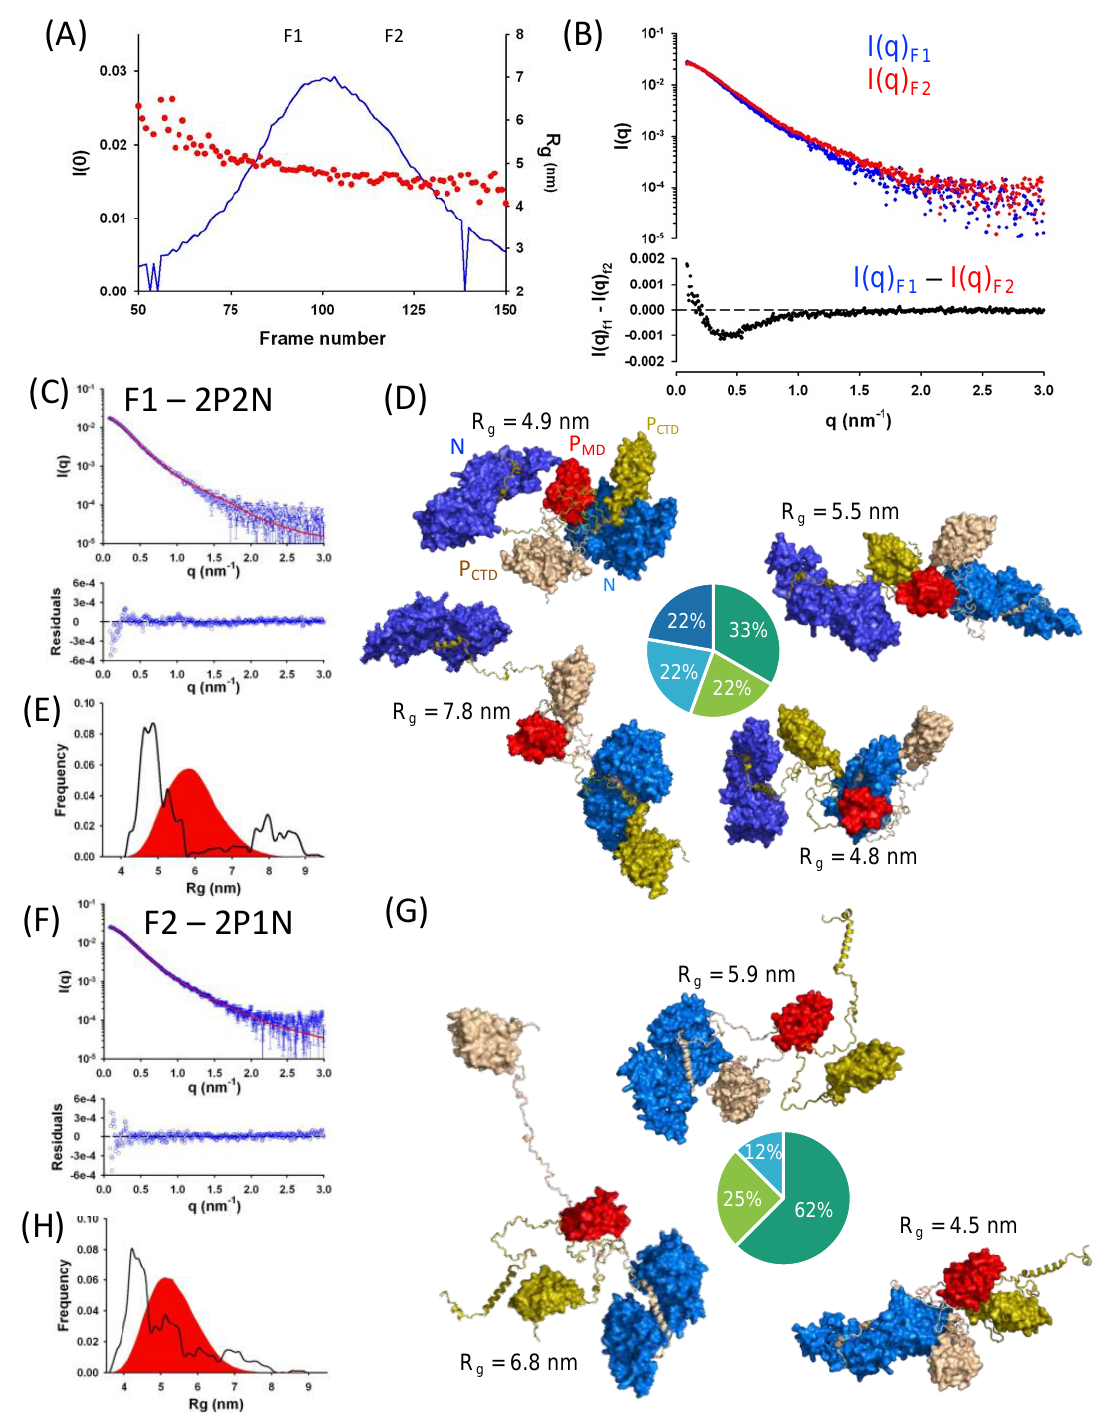
Figure 7. SEC-SAXS of N ∆ 230 − P FL complex. ( A ) SEC-SAXS elution profile and R g across the elution peak; 50 µ L of N ∆ 230 − P FL sample were injected onto a Superdex 200 column and monitored on-line by SAXS. The blue line shows the intensity at zero angle (I 0 ), which is proportional to both MM and concentration. The red dots indicate the values of the radius of gyration calculated from the Guinier approximation at the different time intervals. The shaded areas (labeled F1 and F2) show the frames that were averaged and used for analysis in the next panels. ( B ) Average SAXS profiles at two different positions in the SEC profile. The upper part shows the curves obtained by averaging the individual profiles recorded across the two fractions (F1 and F2) of the SEC elution peak shown in Panel ( A ). The lower part shows the difference scattering profile (I(q) F1 –I(q) F2 ). ( C ) Conformational ensemble modeling by the ensemble optimization method (EOM). The upper panel show the exper- imental F1scattering profile (blue circles) The red line shows back-calculated scattering curve for a selected ensemble of 4 2P − 2N conformers shown in panel E ( 2 = 1.95). The lower panel shows the plot of the residuals (blue circles). ( D ) Representative ensemble of conformers that reproduce the curve at position F1. The pie chart indicates the fraction of each conformer used in the calculated curve. The dimerization domain of P (P MD ) is shown in surface representation in red. The rest of the chains of P are shown in wheat and olive and the C-terminal domains (P CTD ) are shown in surface representation, while the intrinsically disordered regions are shown as cartoons. The N 0 molecules are shown in two shades of blue in surface representation. ( E ) R g distribution. The red area shows